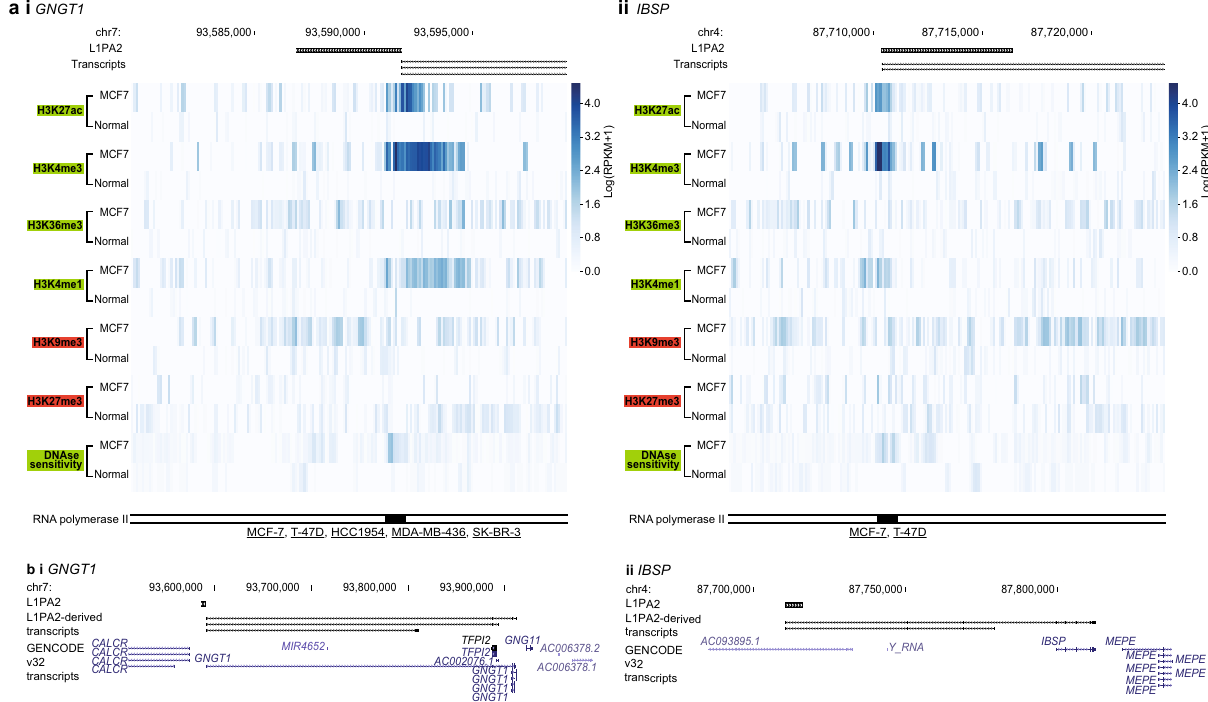
Figure 8. L1PA2 bearing up-regulated transcript TSSs showed cancer-specific, active epigenetic profiles. Examples are shown for ( i ) GNGT1 and ( ii ) IBSP . For each gene, ( a ) histone tail modifications and DNAse sensitivity in MCF7 and normal tissues are shown for the 20 kb region centred on the L1PA2. RNA pol II binding within each L1PA2, as well as the cell lines where the binding was detected, are shown. Underlined cell line names indicate cancerous cell lines. ( b ) The exon structures of the L1PA2-derived transcripts (black), compared to the GENCODE v32 transcripts (blue), are shown 79